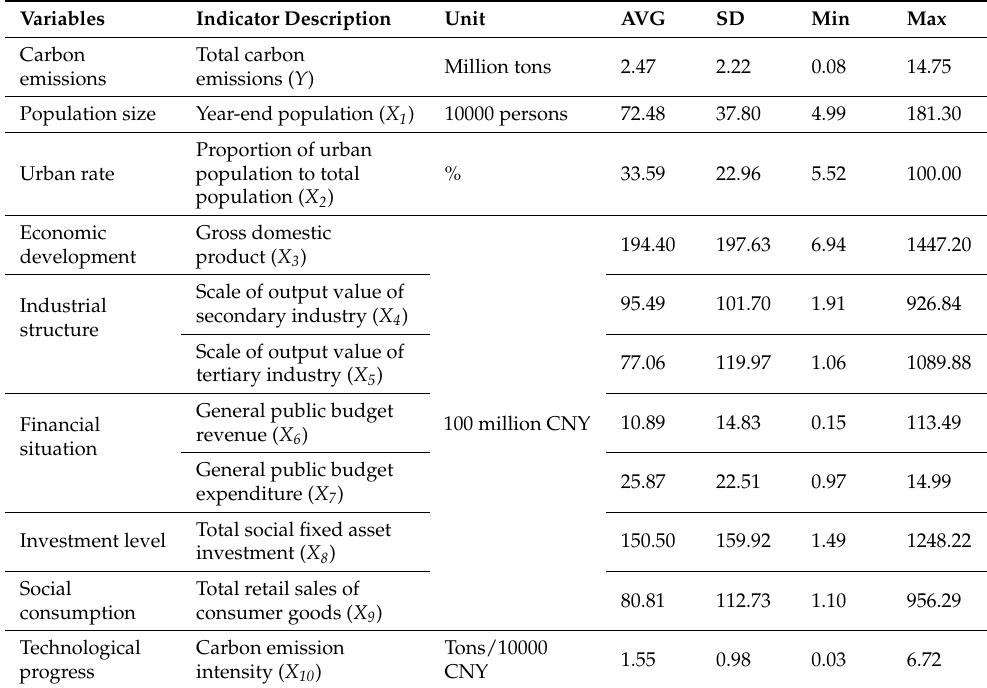
Table 3. Descriptive statistics of